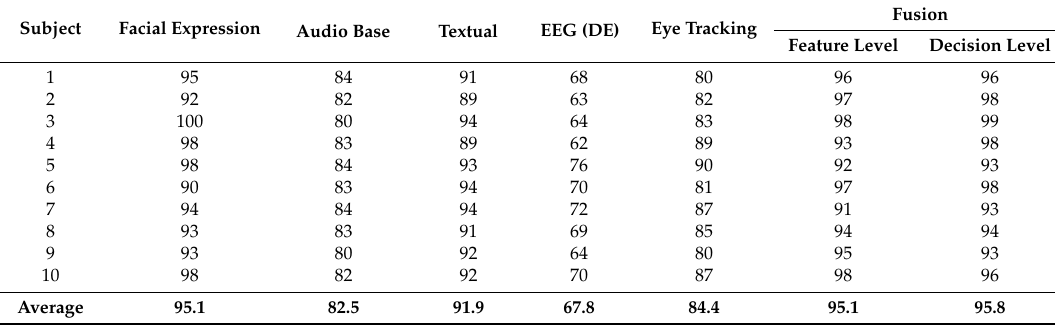
Table 5. The average accuracies of each classifier and fusion method.